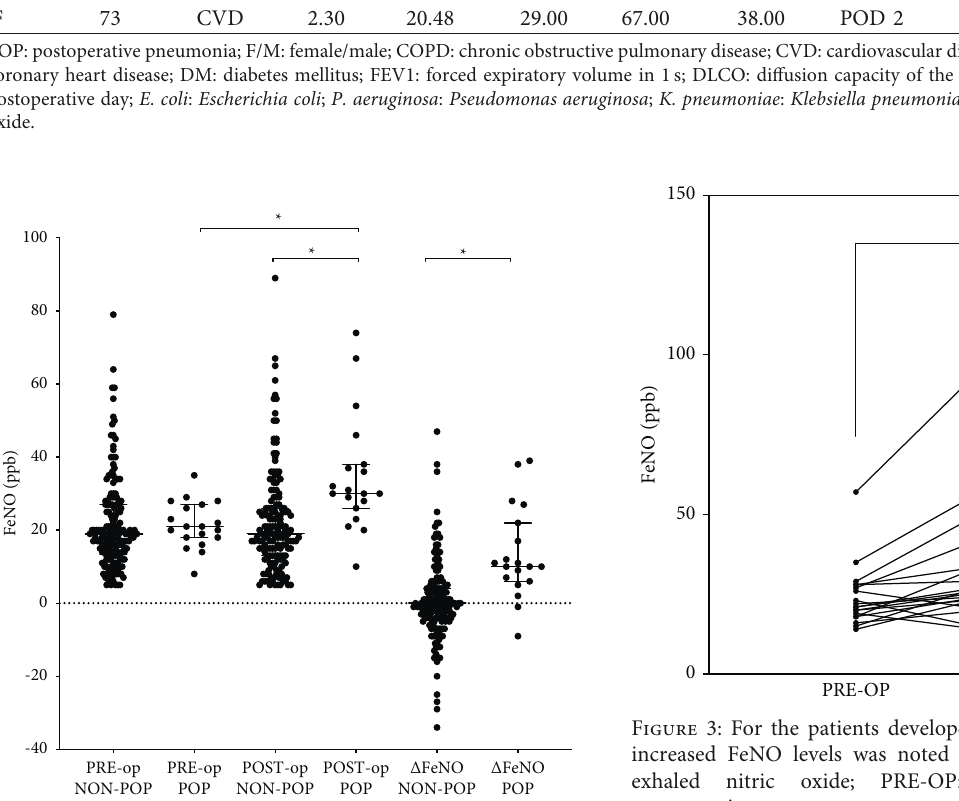
Figure 2: Perioperative FeNO levels and change in FeNO in the POP group ( N � 19) and non-POP group ( N � 164). Dot plots revealed that the post-op-FeNO and ∆ FeNO were higher in the POP group than those in the non-POP group ( P < 0 . 001). For patients with POP, there was a significant difference in the FeNO level before and after the surgery ( P < 0 . 001). For patients without POP, pre-op-FeNO and post-op-FeNO did not show a significant difference ( P � 0 . 7841).